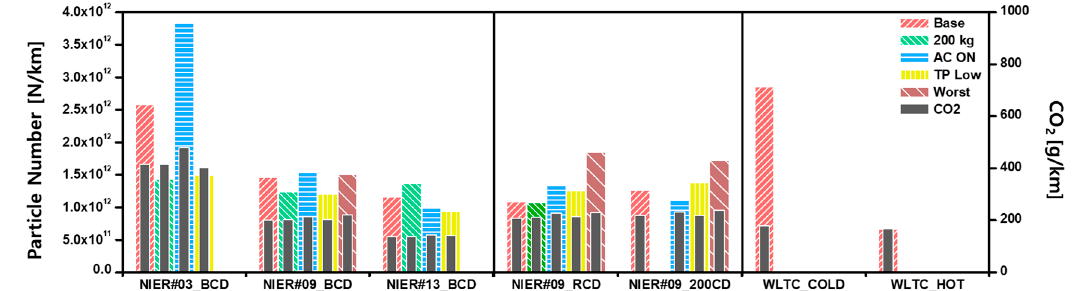
Figure 3. Particle number and CO 2 emissions of each test mode and condition.